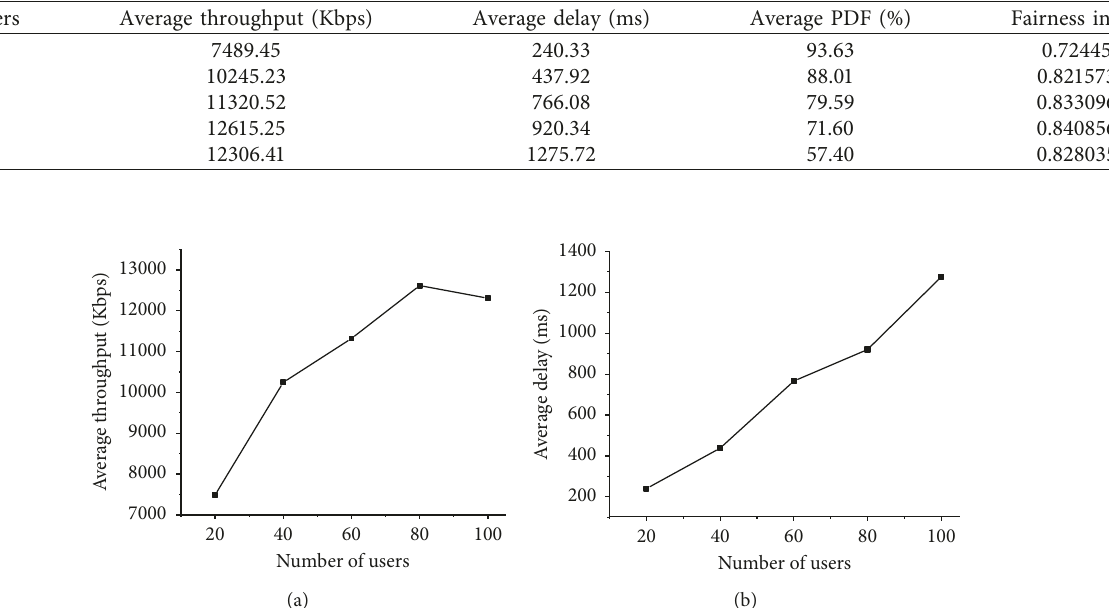
Figure 5: Performance of the system for varying number of users in LTE network. (a) Average throughput. (b) Average delay.